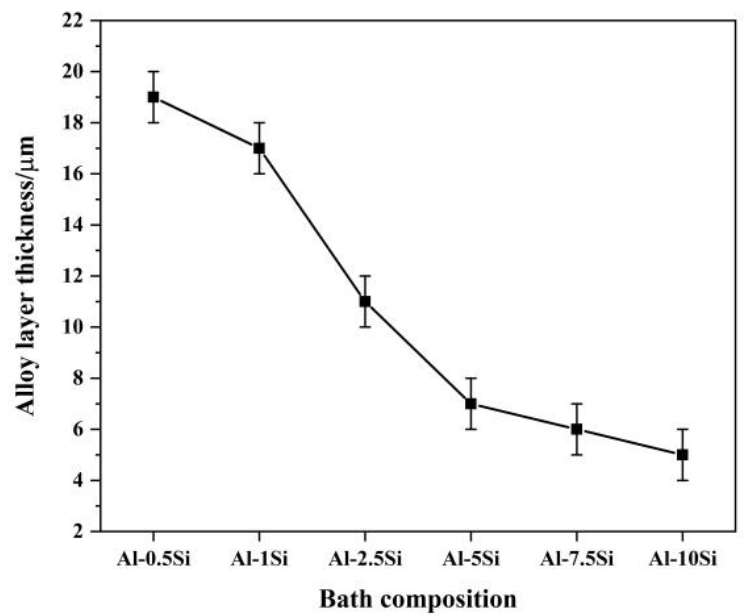
Figure 3. Cross-sectional micrographs of coatings of Q345 steel hot-dipped in baths with different Si addition at 750 °C for 30 s. ( a ) 0.5Si, ( b ) 1Si, ( c ) 2.5Si, ( d ) 5Si, ( e ) 7.5Si, and ( f ) 10Si.